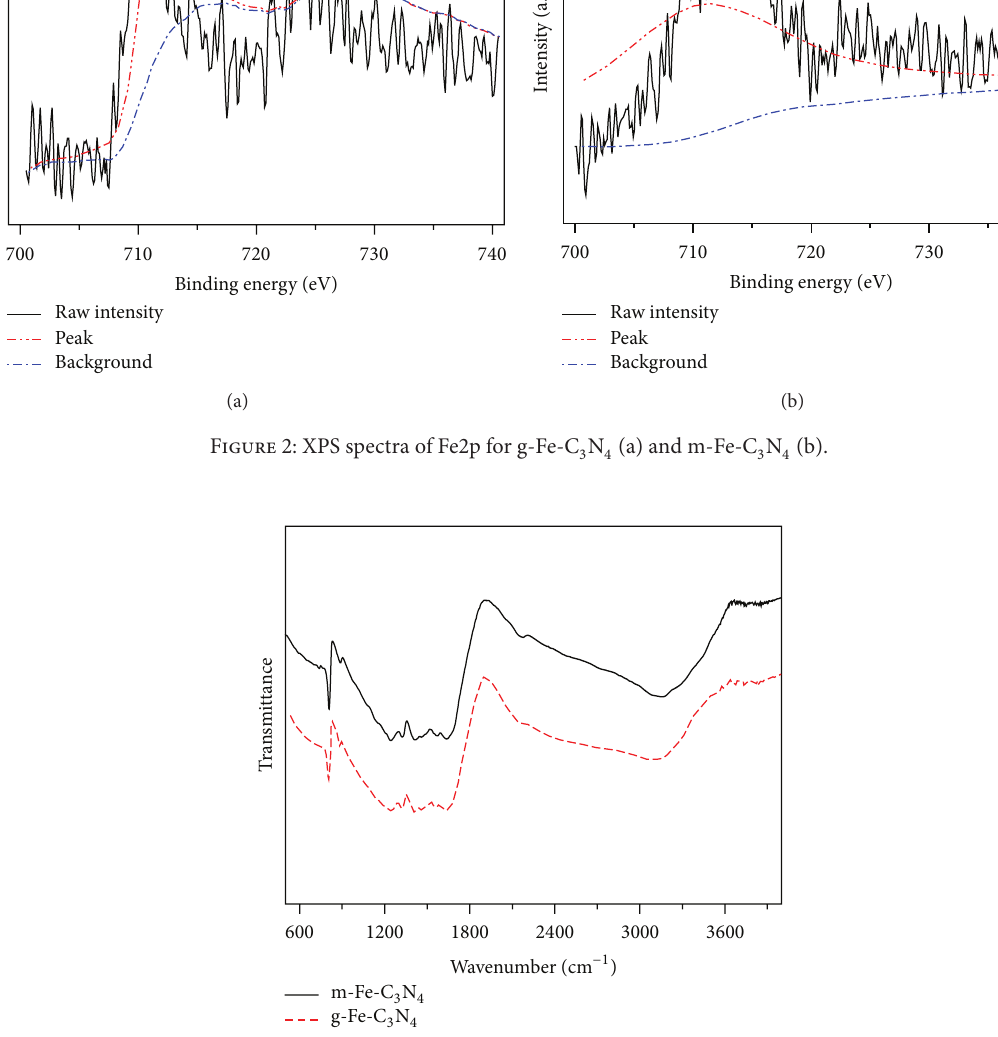
Figure 3: FTIR spectra of the g-Fe-C 3 N 4 and m-Fe-C 3 N 4